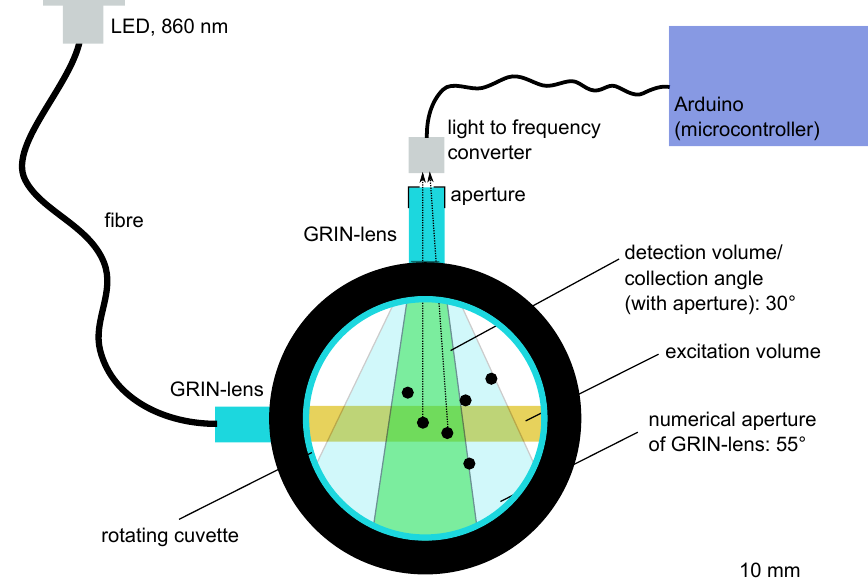
Figure 1. Sketch of GRINephy, which shows the main parts of the sensor including the illumination part, the detection unit, and the chamber parts.